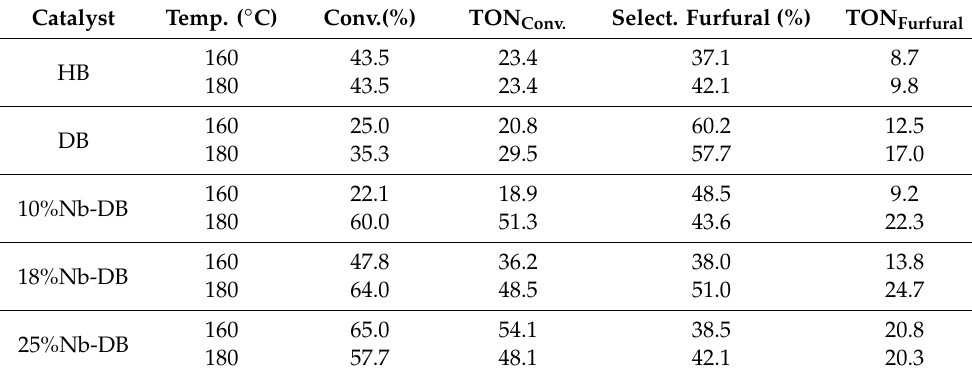
Table 7. Xylose conversion, TON conv. (mole converted xylose/mole acid sites), selectivity for furfural and TON Furfural (mole obtained Furfural/mole acid sites) at temperatures of 160 °C and 180 °C.